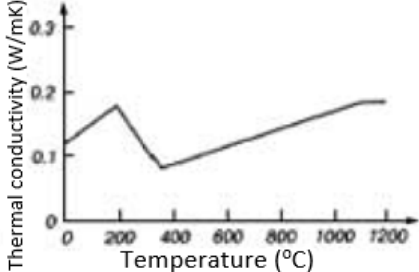
Figure 8. Changing of thermal conductivity of wood with temperature [3]